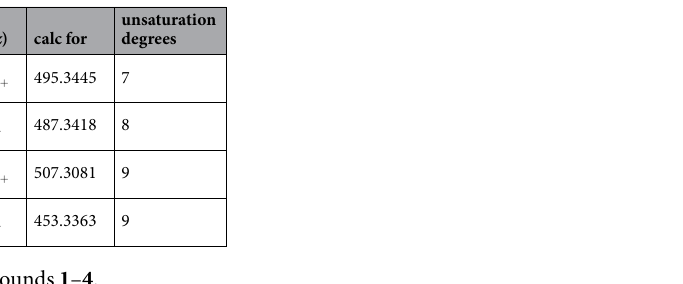
Table 1. The MS data of compounds 1 – 4